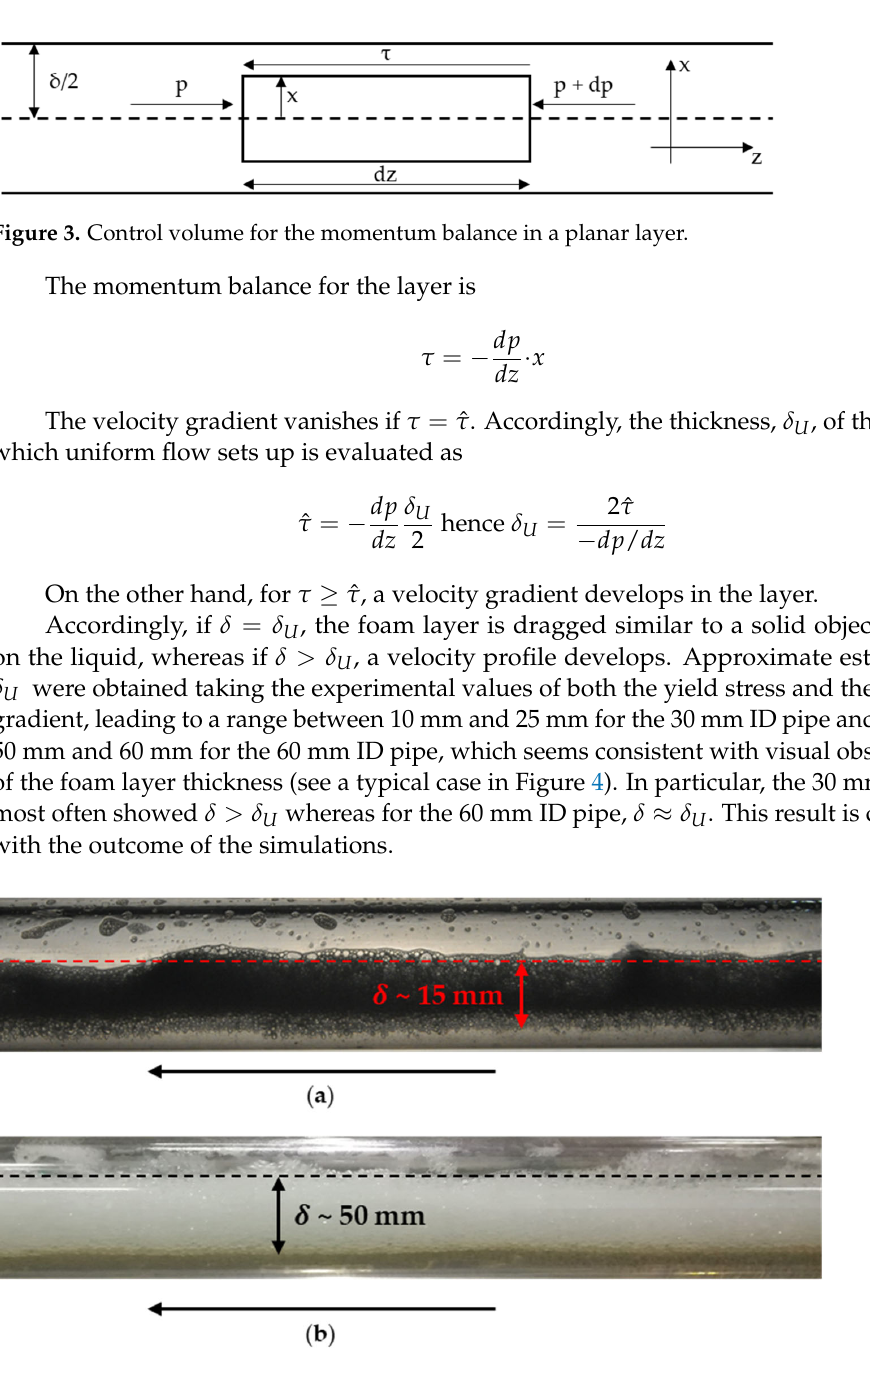
Figure 4. Qualitative comparison with visual observations: ( a ) ID = 30 mm and J L = 0.24 m/s, J G = 2.80 m/s, and δ U = 12 mm, ( b ) ID = 60 mm and J L = 0.06 m/s, J G = 0.41 m/s, and δ U = 53